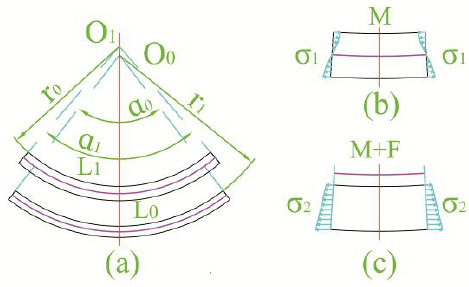
Figure 12. Spring-back model. ( a ) Deformation during spring-back; ( b ) stress state of general bending; ( c ) stress state of spinning groove.